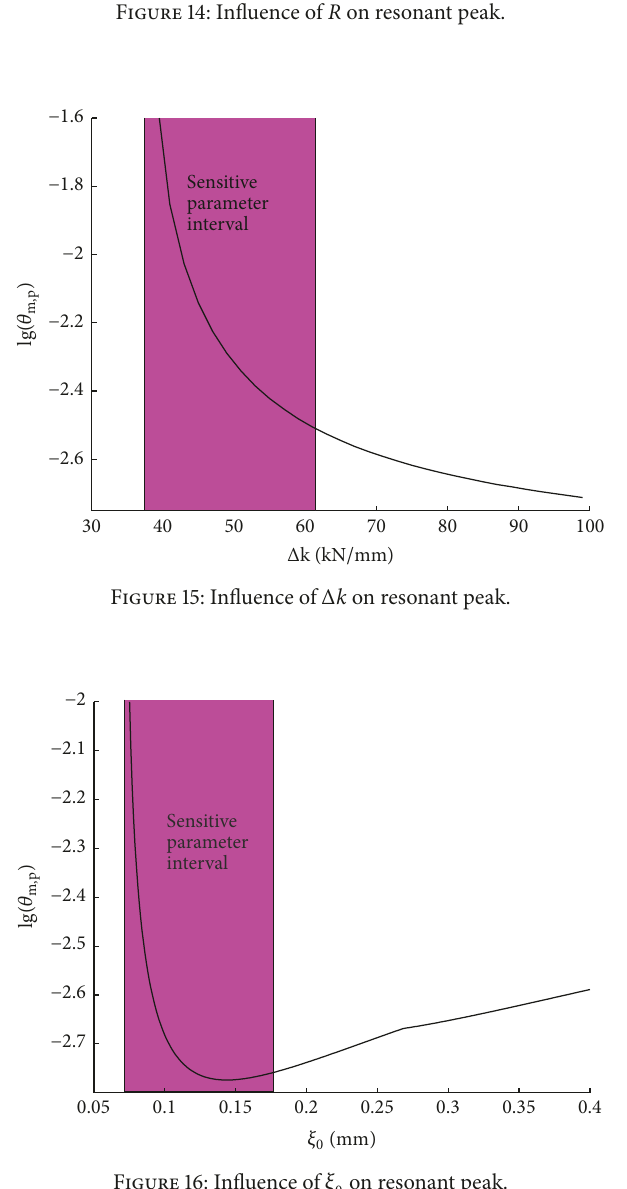
Figure 16: Influence of 𝜉 0 on resonant peak.